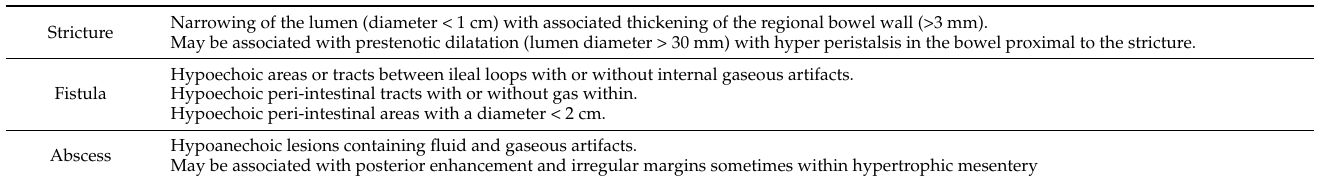
Table 1. IUS definition of penetrating complications of CD from EFSUMB [24].